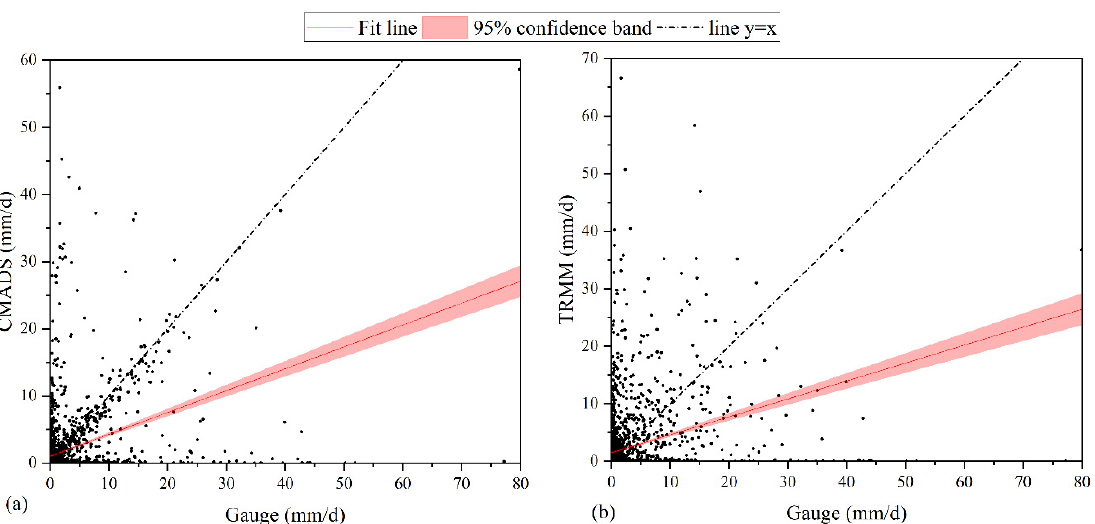
Figure 4. Scatterplot of the CMADS and TRMM records compared with Gauge records at a daily scale: ( a ) comparison of CMADS and Gauge and ( b ) comparisons of TRMM and Gauge. Note that the straight lines that pass through the origin are dividing lines with an angle of 45 ◦ to the x-axis, which means that the precipitation products overestimated the rainfall if the point is higher than this